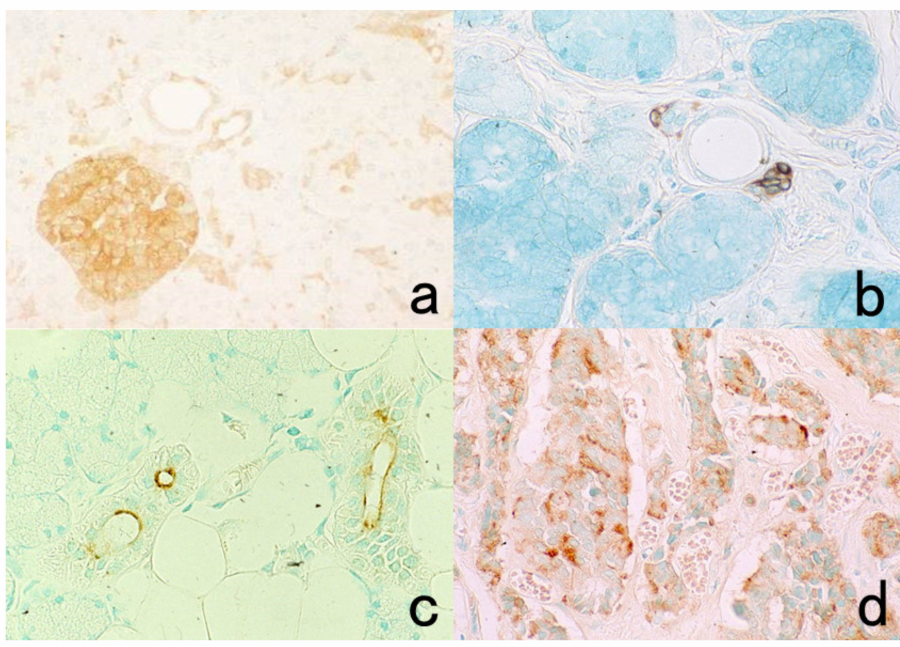
Figure 53. Expression of specific markers in unrelated cells. ( a ): Neuron-specific enolase (NSE) in the normal pancreas, ( b ): glial fibrillary acidic protein (GFAP) in the normal salivary gland, ( c ): prostate-specific antigen (PSA) in the normal salivary gland and ( d ): prostatic acid phosphatase (PAcP) in rectal carcinoid tumor. NSE is expressed not only in islets but also pancreatic ductal cells ( a ). In the salivary gland, GFAP immunostains some of the myoepithelial cells ( b ), and PSA antiserum decorates the apical cytoplasm of the ductal cells ( c ). Rectal carcinoid tumor cells are frequently immunoreactive for PAcP ( d ). The nuclei are counterstained with methyl